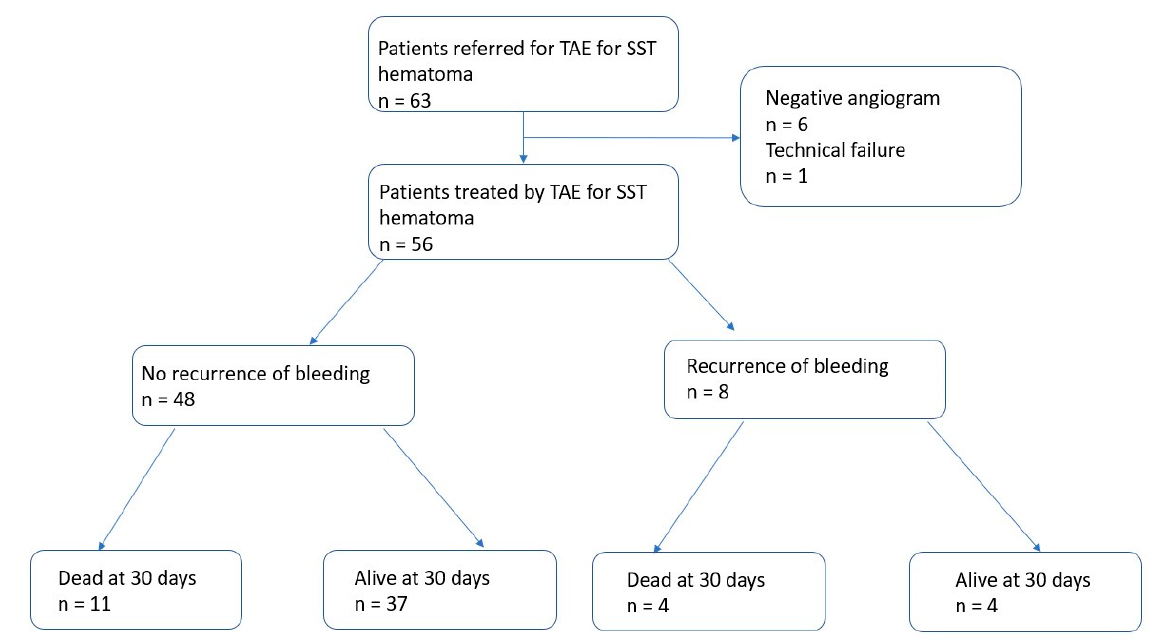
Figure 2. Flowchart of patient outcomes.